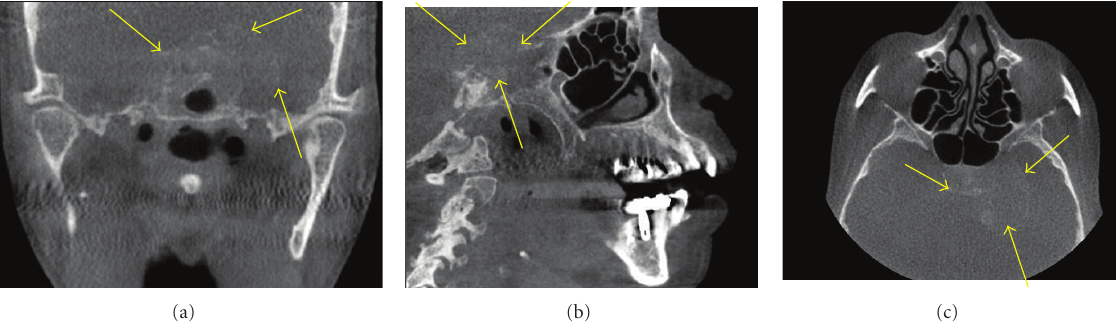
Figure 9: A malignancy seen as a soft tissue mass (arrows) in the sella region, which is causing extensive destruction in the osseous components of the bone in the sella region and encroaching into the adjacent areas on these MPR